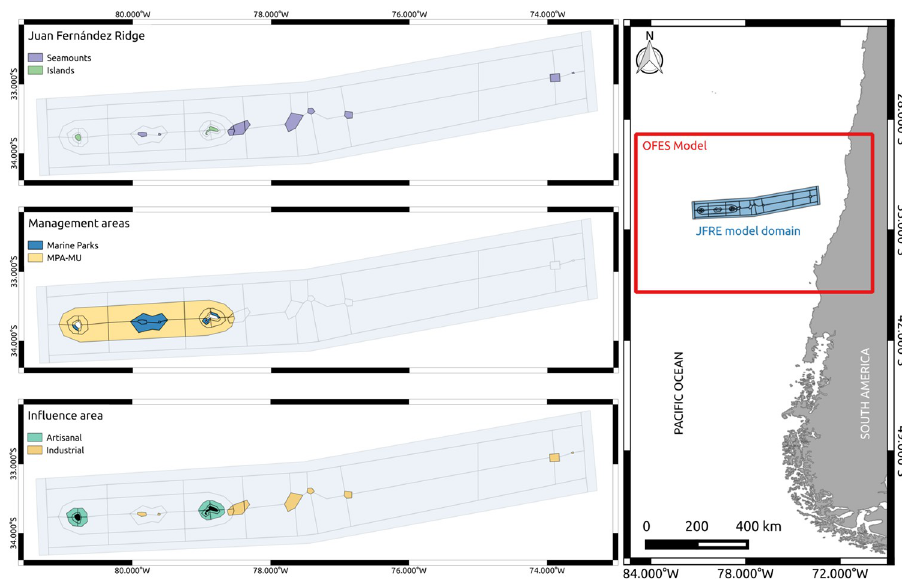
Fig 1. Atlantis JFRE model domain. The red square represents the area of coverage of the hydrodynamic OFES model subset. The maps in the left represent the characteristics that were considered for the division of the polygons: The geographic structure of the ridge (Islands and seamounts); Management area (Marine parks and Marine protected areas with multiple uses; MPA-MU); and areas of influence of fishing activity (Industrial and artisanal fleets).